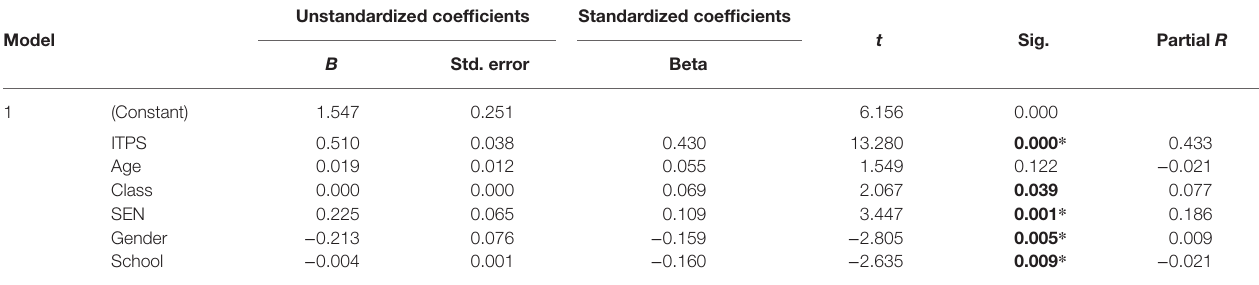
TABLE 4 | Multiple regression statistics for examining the predictors of students’ perceived social inclusion levels.